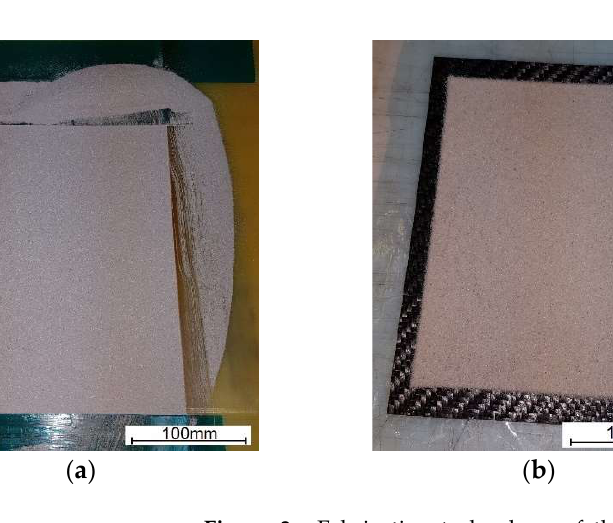
Figure 3. Fabrication technology of the PL: ( a ) use of a template; ( b ) remove of a template; ( c ) preparation for vacuum bagging technology.